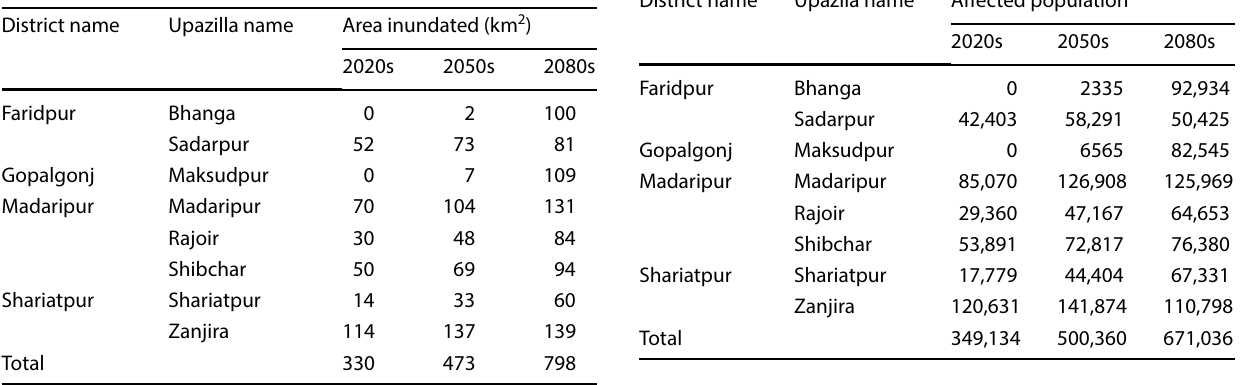
Table 3 Upazila-wise flood inundated area (km 2 ) for RCP 8.5 Sce-